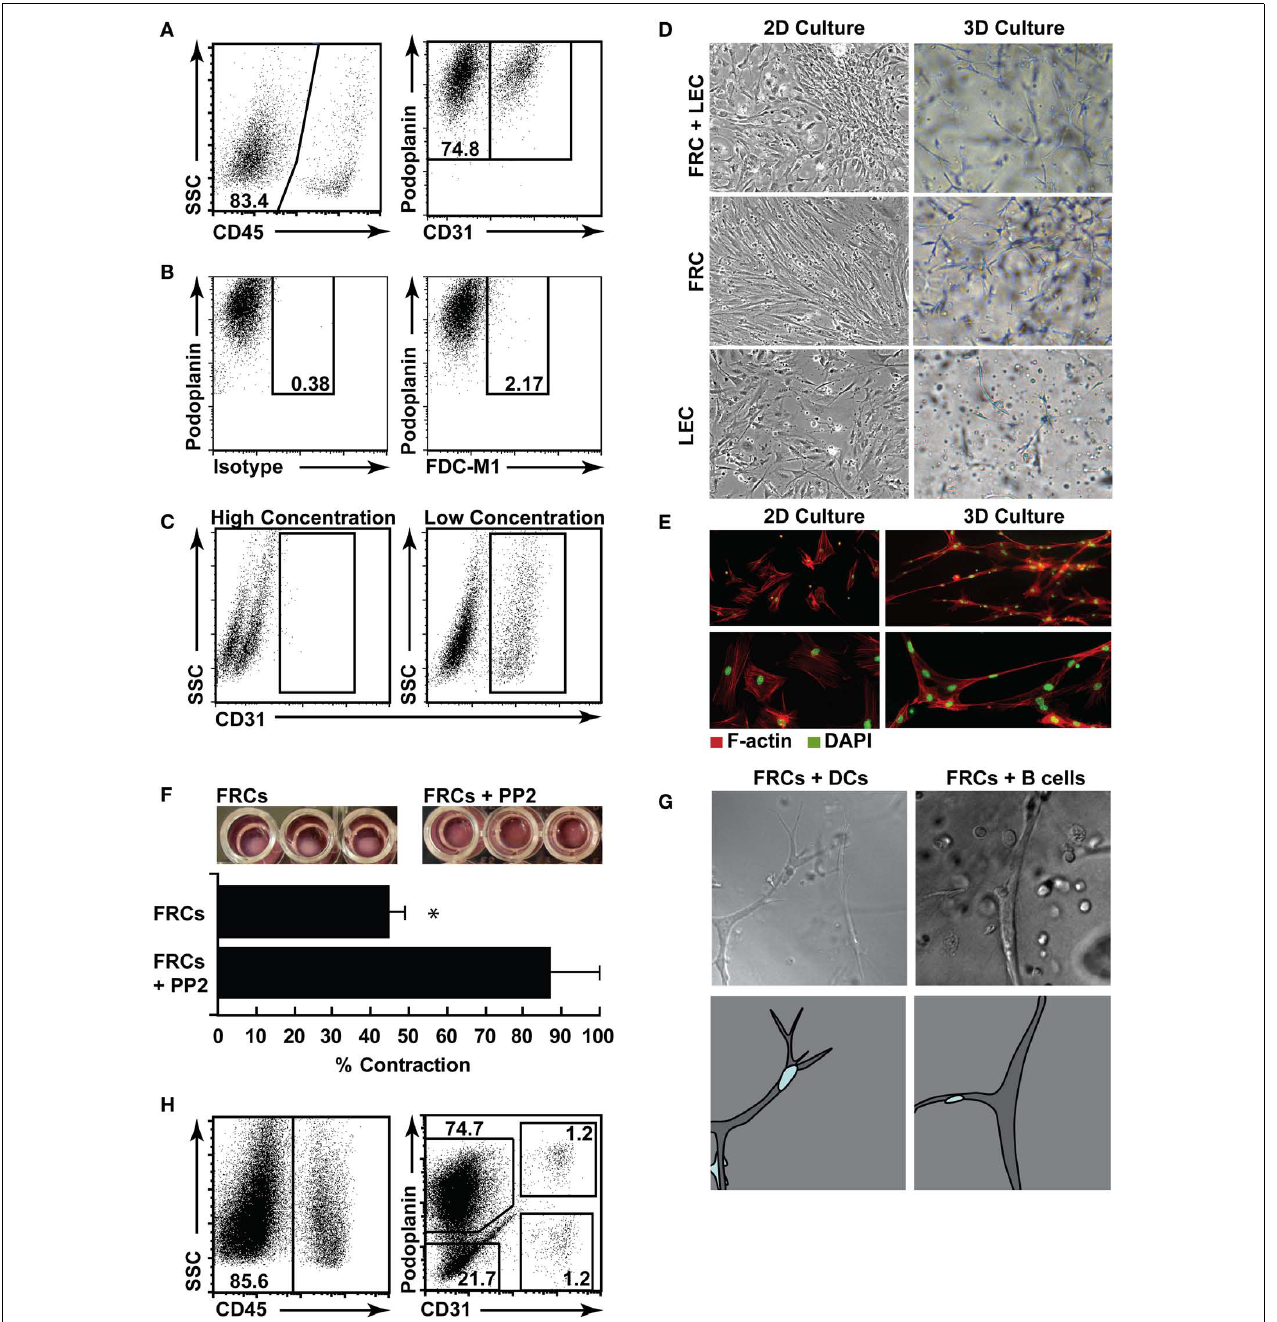
(E) F-actin (red) and DAPI (green) were used to stain purified FRCs in 2D or 3D to highlight networks. Images represent n = 3 independent experiments. (F) Purified FRCs were placed in 3D culture in a 96 well plate with or without PP2. After 24–36h, gel contraction was quantified. Images are representative of n = 3 independent experiments. Bar graph depicts mean + SD, P < 0.05, T -test. (G) Purified FRCs were placed in 3D cultured with purified dendritic cells (DCs) or B cells, then images were sequentially acquired every 90s. Stills from Supplemental Movies 1 (DCs) and 2 (B cells) are shown (upper panel), original magnification: 20 × . Lower panel shows a cartoon of the imaged stromal cell (gray) and the relevant migrating leukocyte (blue). (H) Human lymph nodes were digested, and single cell suspensions put into culture for 7days, then trypsinized and stained for flow cytometric